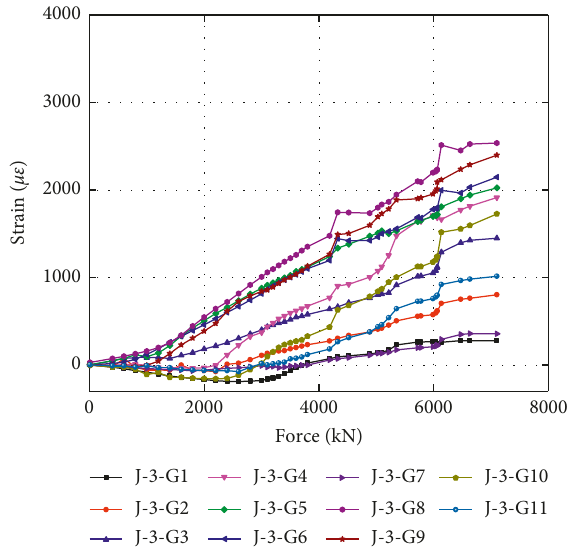
Figure 20: Strain curve of J-1.